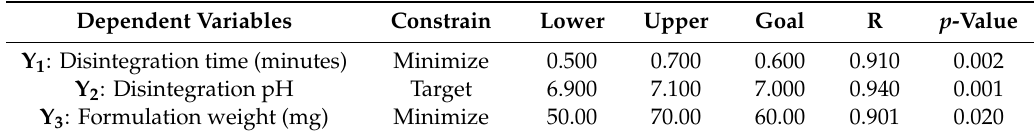
Table 6. Model summary of optimization constrains and statistical significance of the selected response